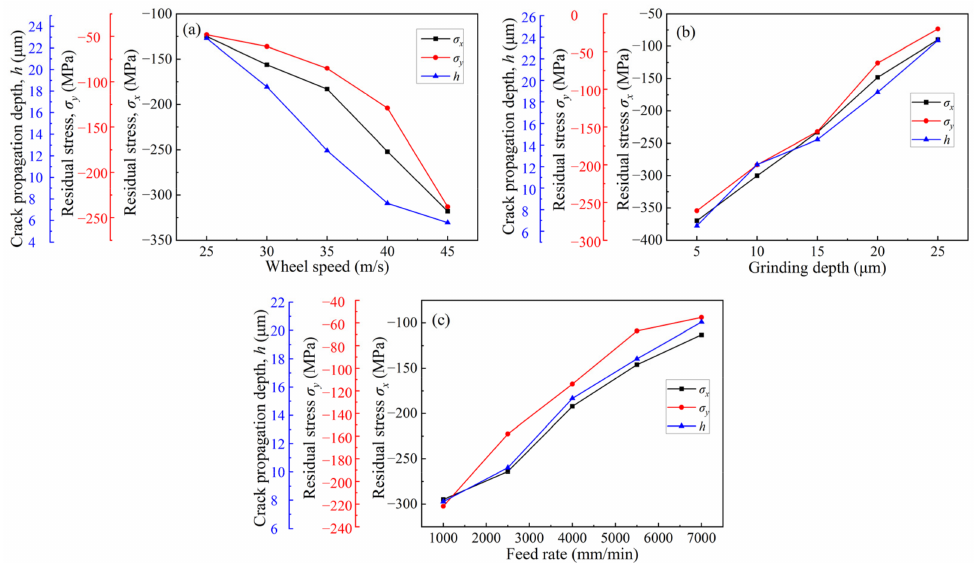
Figure 10. Surface residual stress and crack propagation: ( a ) Wheel speed; ( b ) Grinding depth; ( c ) Feed rate.